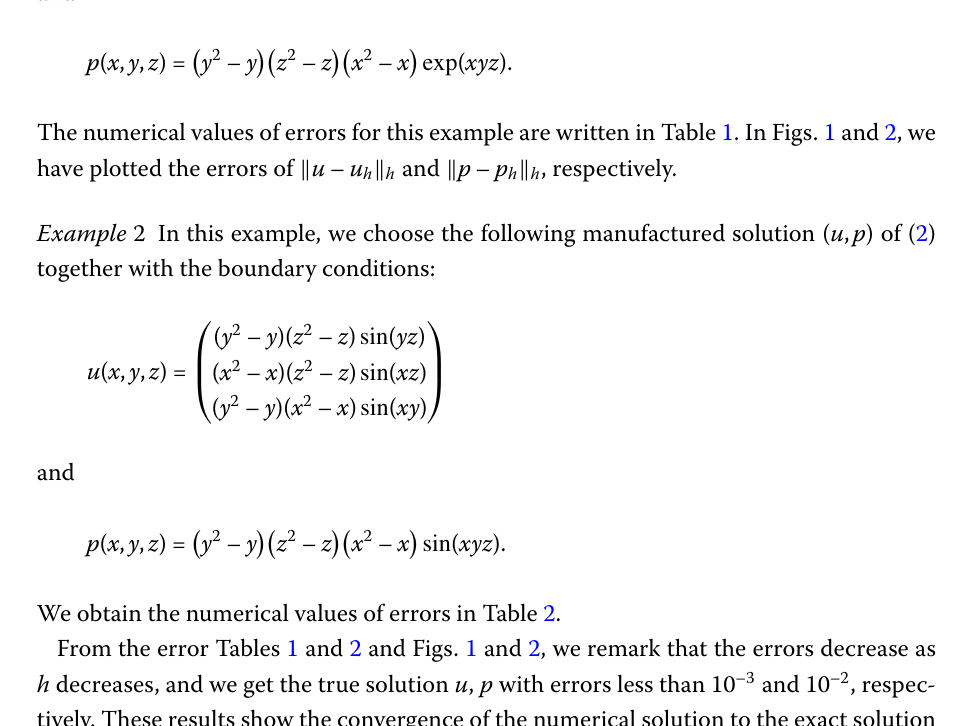
Figure 1 Errors (cid:10) u – u h (cid:10) h